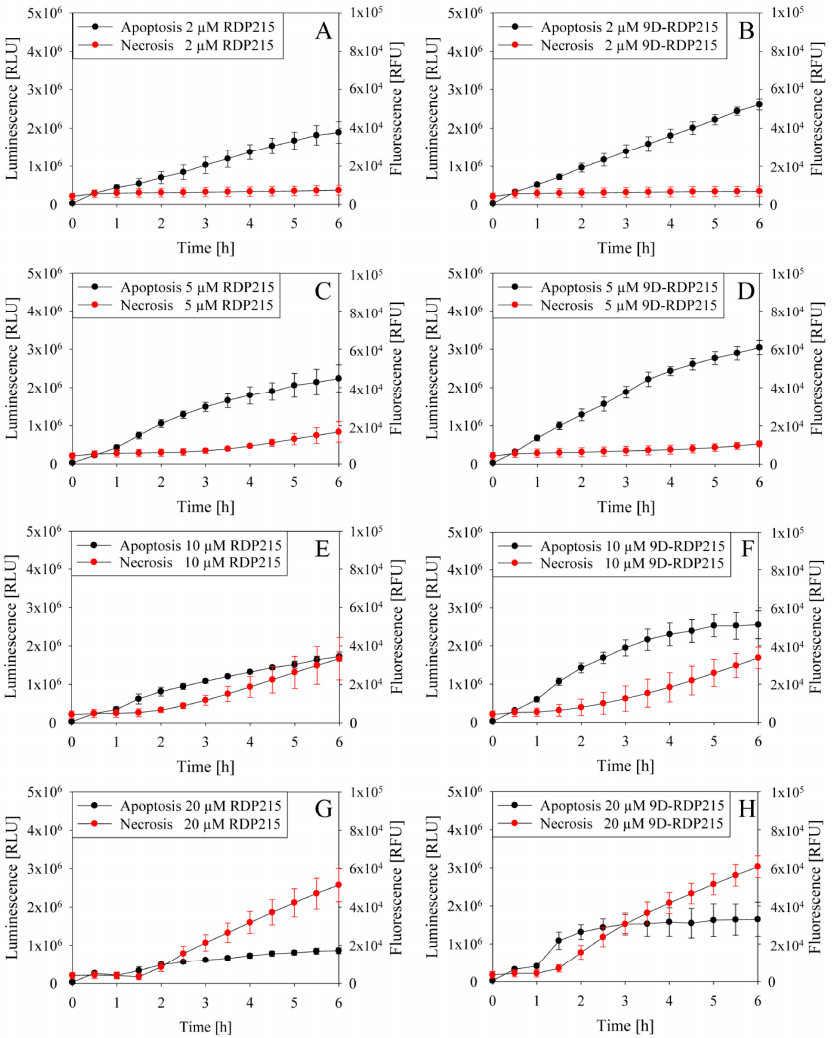
Figure 11. A study of RDP215 and 9D-RDP215-induced cell death in melanoma A375 by apoptosis or necrosis. ( A ) RDP215 2 µM; ( B ) 9D-RDP215 2 µM; ( C ) RDP215 5µM; ( D ) 9D-RDP215 5 µM; ( E ) RDP215 10 µM; ( F ) 9D-RDP215 10 µM; ( G ) RDP215 20 µM; ( H ) 9D-RDP215 20 µM. Apoptosis (black; left scale luminescence) and necrosis (red; right scale fluorescence) signals were measured every 30 min for 6 h. Background subtracted signals are depicted. The mean values with standard deviations are derived from 4 independent determinations. Both peptides kill melanoma cells by induction of apoptosis. However, the D-peptide causes higher levels of apoptosis and, therefore, a higher cell death rate.